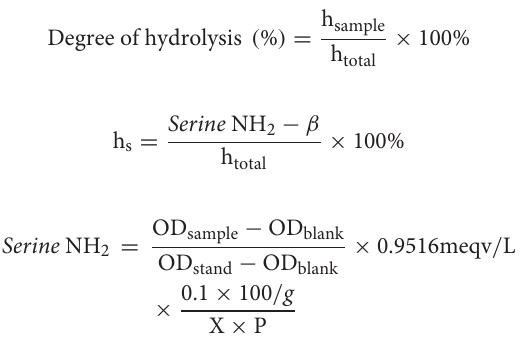
FIGURE 1 | Preliminary evaluation of fried and non-fried instant noodle products. (A) appearance; (B) sensory evaluation.